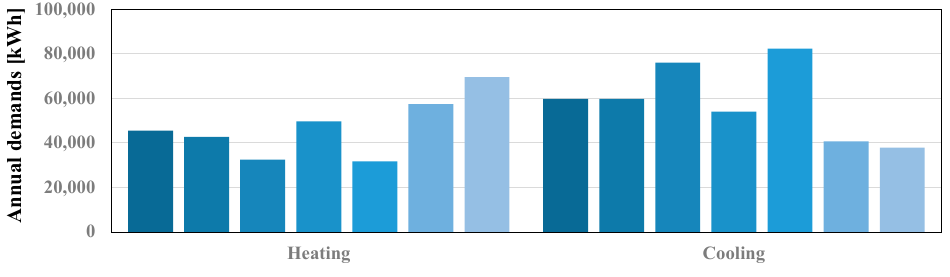
Figure 11. Heating and cooling annual energy demand for the building. The energy demands correspond to the current building and the building subjected to the different retrofit interventions.